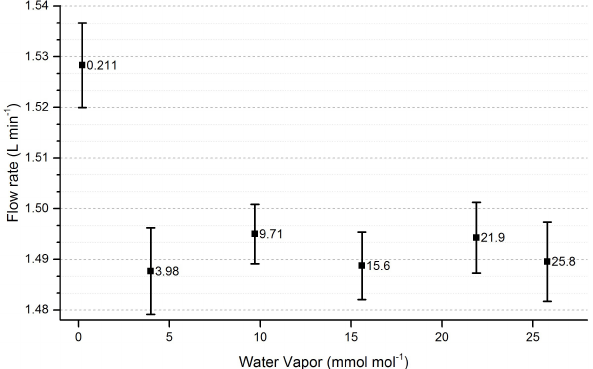
Fig. A2. Flow rate determined with the bubble meter, corrected for ambient pressure and temperature, against water vapor mole frac- tion for MFC 5 (Tylan FC-260) operated at a constant flow rate set point. Each point shows the mean flow rate and the error bars rep- resent the standard error with a sample size of 20. The numbers to the right of each point correspond to the water vapor content deter- mined with the LI-7000.